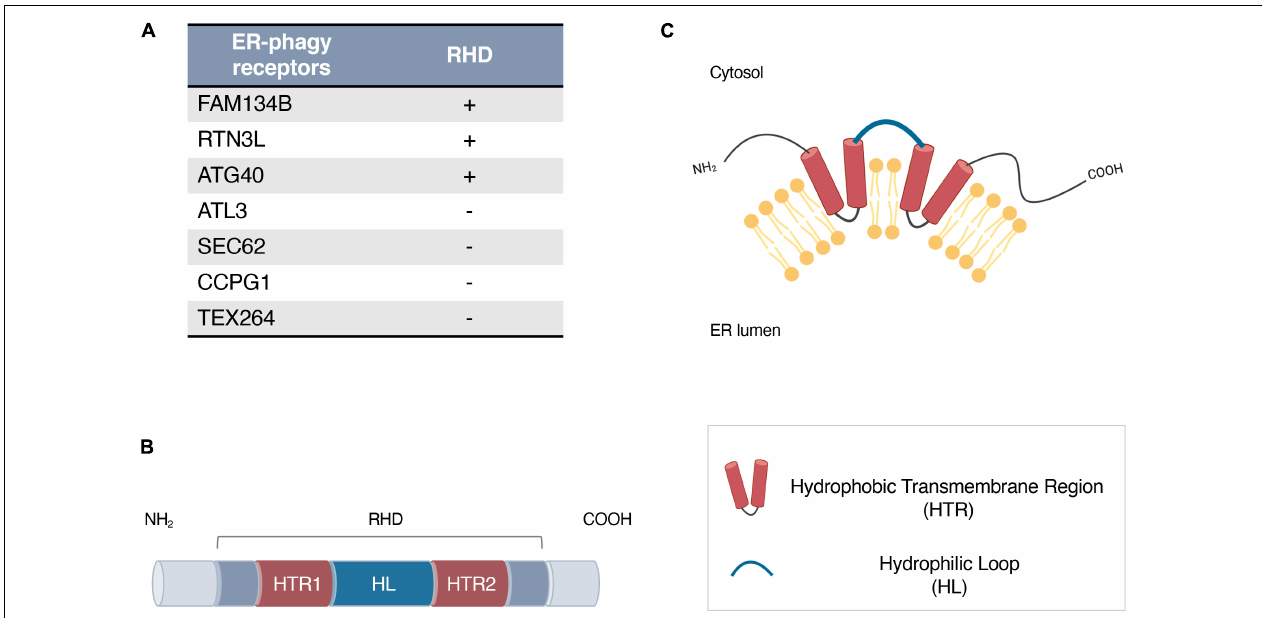
FIGURE 1 | (A) ER-phagy receptors in mammals (FAM134B, SEC62, RTN3, CCPG1, ATL3, and TEX264) and in Saccharomyces cerevisiae (ATG40) harboring or not a Reticulon Homology Domain (RHD). (B,C) Schematic representation of the RHD structure (B) and topology (C) . An RHD consists of two large hydrophobic transmembrane segments (red, HTR1, HTR2), separated by a hydrophilic loop (blue,